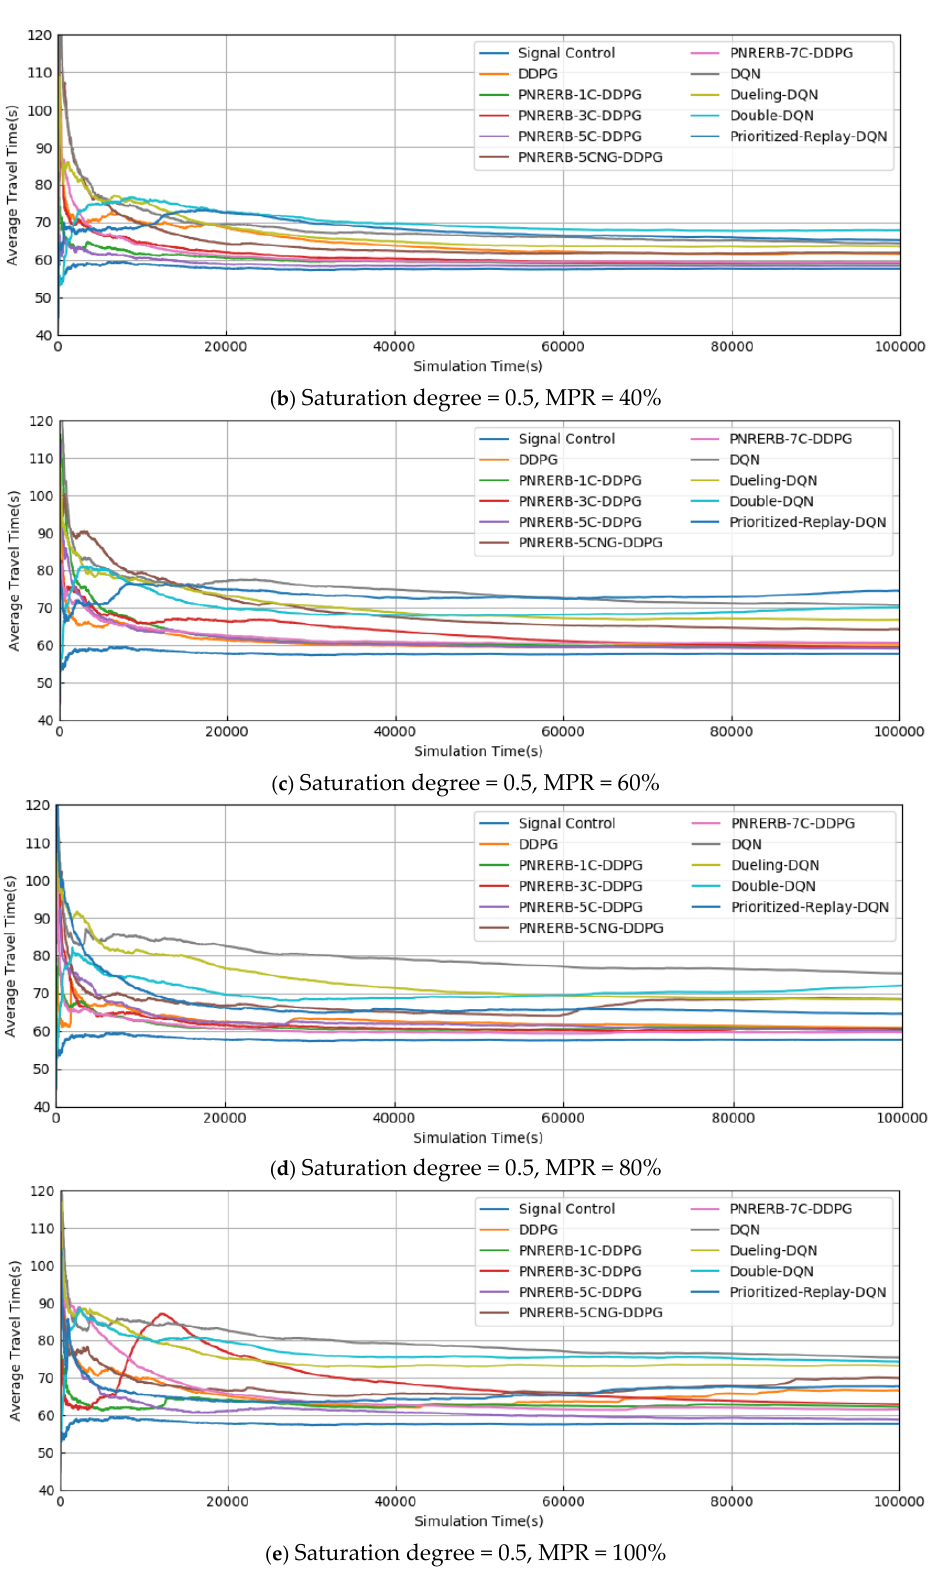
Figure 5. ATT for different CAV penetration rates under saturation degree 0.5.